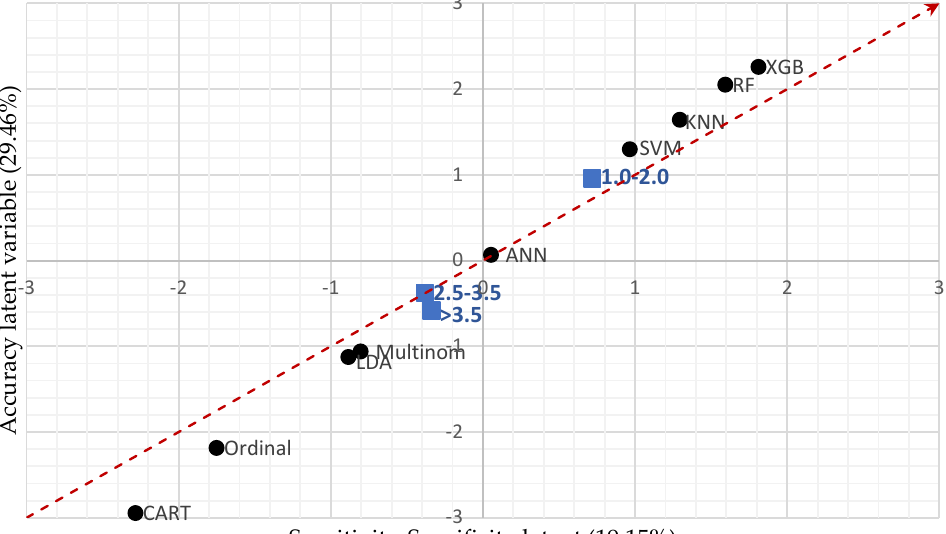
Figure 3. A plot of the accuracy and sensitivity–specificity latent variables from their first dimension/component obtained through a factor analysis of mixed variables (a combination of principle component and multiple correspondence analyses) procedure on measures of performance for the prediction of ewe BCS during pregnancy diagnosis. Dots (red sphere: model, blue square: BCS class). Dotted diagonal line indicates a balance between accuracy and sensitivity–specificity. If dot is above, then model or BCS class was more accurate than sensitive–specific while the reverse indicates that the model was more sensitive than accurate. The further and more positive a model is along the diagonal line, the greater and better is its prediction power. The variance explained by each extracted first dimension for each latent variable (accuracy, sensitivity–specificity) is given in parenthesis along the axes.